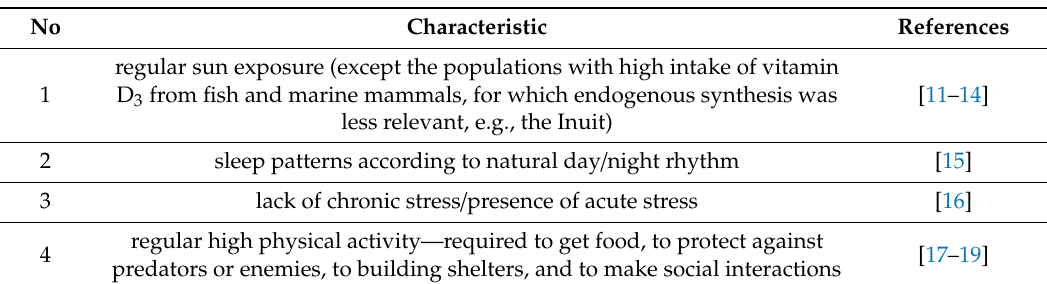
Diet and lifestyle characteristic of hunter-gathers which resembled the habits of Paleolithic